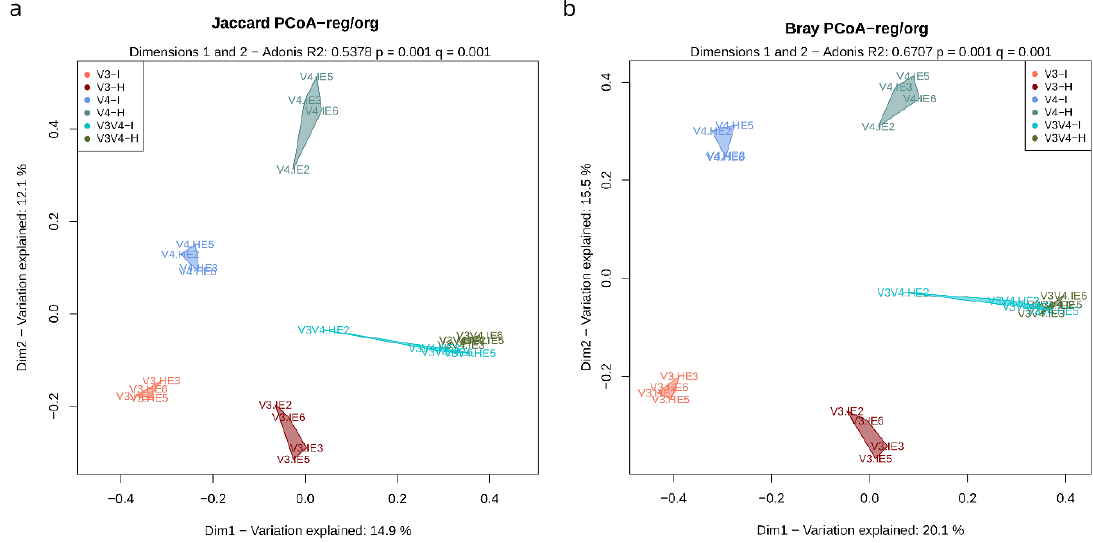
Figure 9. Multidimensional scaling of differences in OTU composition and abundance. Polygons highlight each cluster formed by region-organ sets. ( a ) The first two linear combinations of the PCoA constructed from the Jaccard similarity index (composition) matrix, comparing all samples. ( b ) First two dimensions of the principal coordinate analysis (PCoA) from the Bray–Curtis (abundance) dissimilarity index comparing all samples. Adonis p values were calculated between groups and false discovery rate (FDR)-adjusted for the 10,000 Montecarlo iterations.